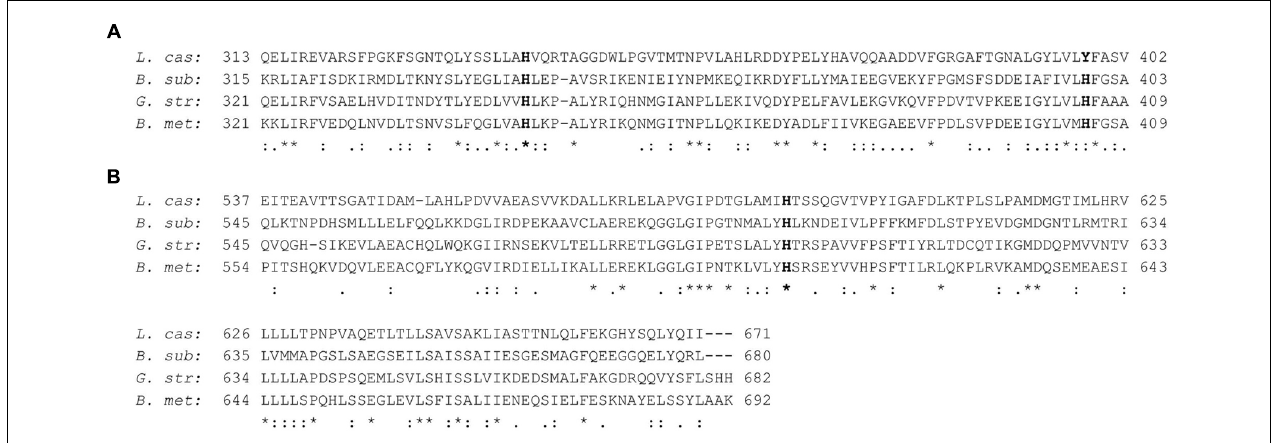
FIGURE 6 | Amino acid sequence alignment of the PRD2 (A) and EII Mtl (B) domains of various MtlR proteins. The known regulatory sites are in boldface, conserved sequence ( ∗ ), conservative mutations (:), semi-conservative mutations (.), and non-conservative mutation ( ). The alignment was performed with T-Coffee (Notredame et al., 2000). The GenBank accession numbers of the sequences are as follows: L. cas : Lactobacillus casei BL23, FM177140.1; B. sub : B. subtilis ssp. subtilis str. 168, CP010052.1; G. str: Geobacillus stearothermophilus ATCC 7954, U18943.1; B. met : B. methanolicus MGA3, CP007739.1.